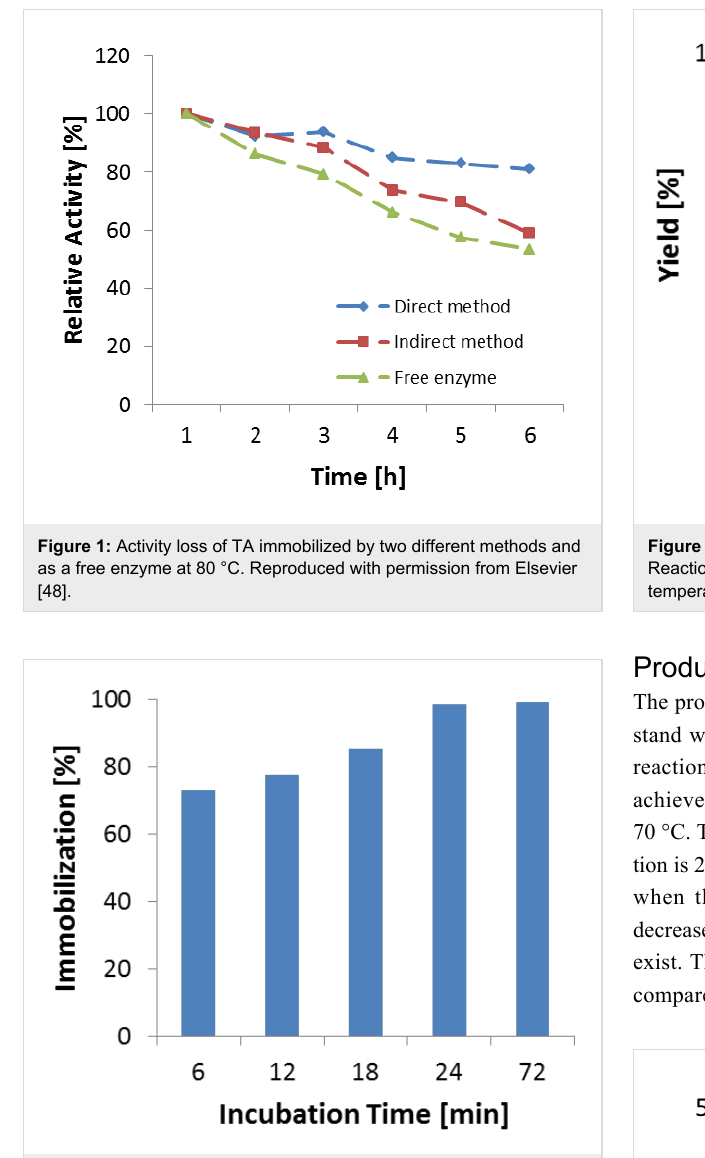
Figure 2: Degree of immobilization versus incubation time.